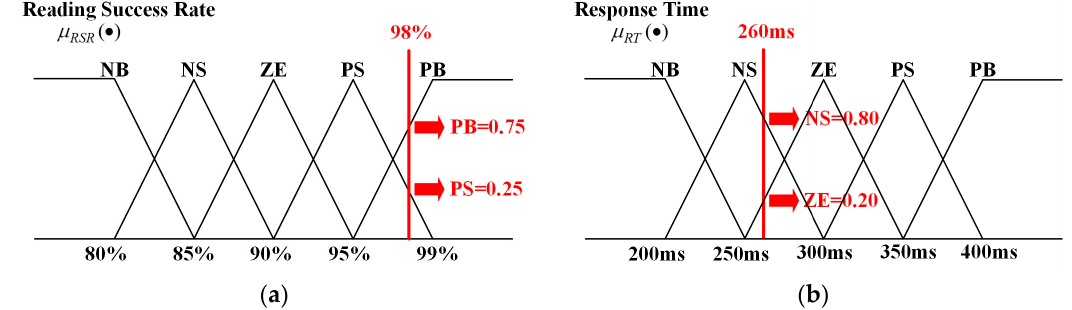
Figure 4. Minimum Inference Engine. ( a ) Reading Success Rate; ( b ) Response Rate. Table 2. Results of Activated Fuzzy Rules.